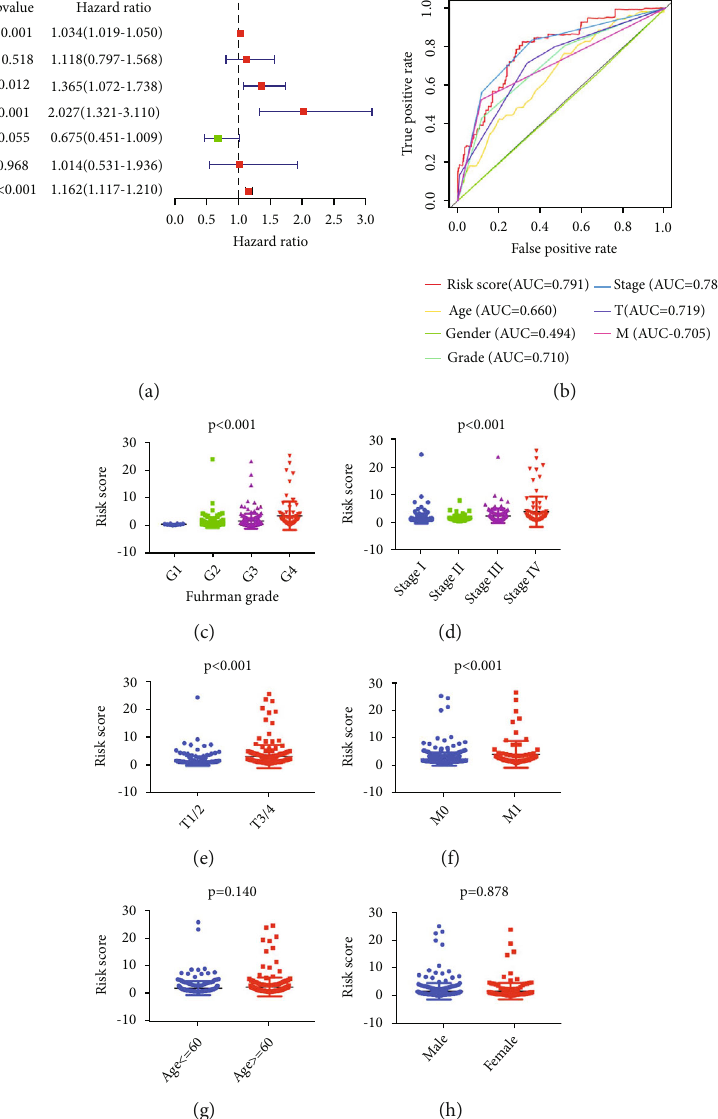
Figure 3: Autophagy-related signature was regarded as an independent factor for ccRCC diagnosis. (a) Multivariate Cox regression analyses were for the veri fi cation to the independent value on autophagy-related manifestation, so that the OS would be evaluated. (b) A ROC analysis on the OS for the manifestation and the clinicopathologic parameters. (c) – (h) Clinicopathological signi fi cance of the OS-related prognostic ccRCC